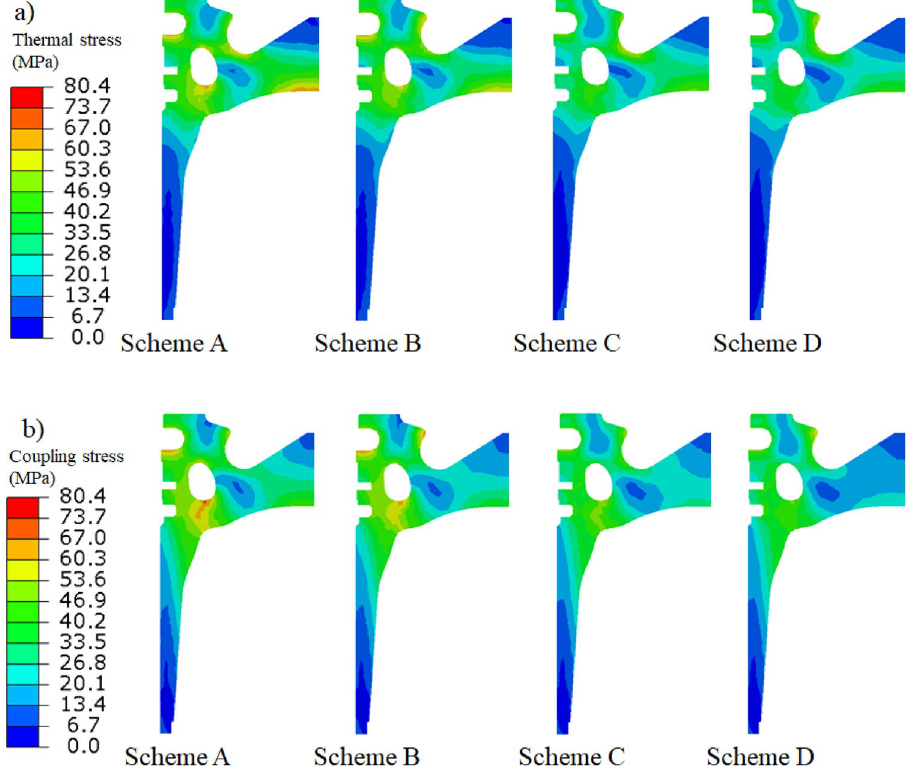
Figure 10. Distribution results of ( a ) thermal stress of the piston and ( b ) thermo-mechanical coupling stress of the piston.